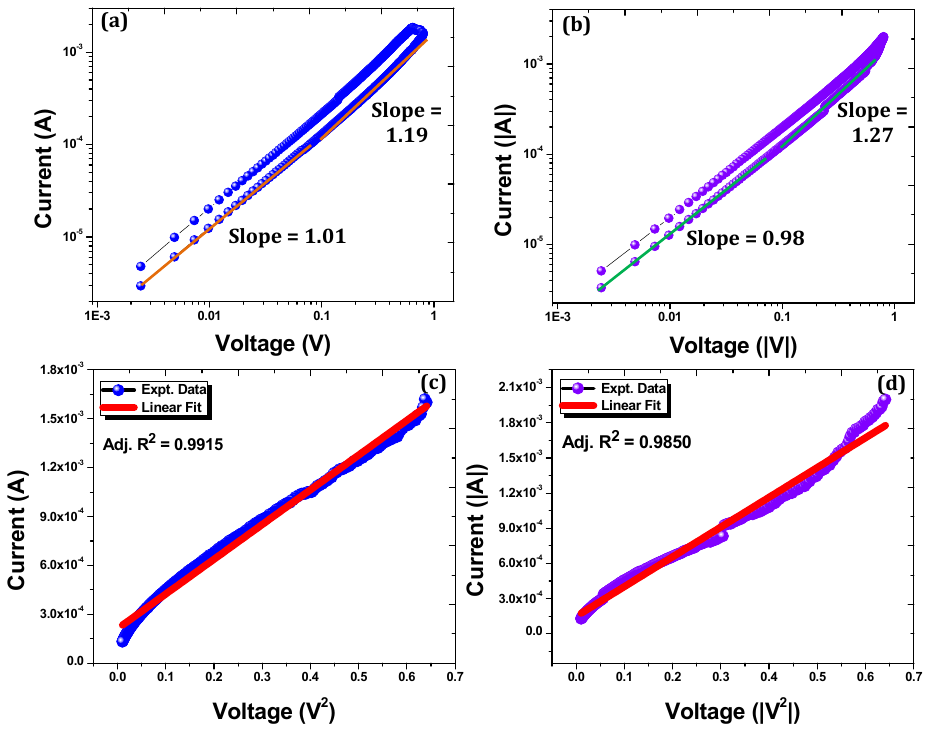
Figure 6. ( a ) Log–log I–V characteristics of the Ag/ZnO/FTO thin film memristive device during ( a ) positive and ( b ) negative bias. Child’s law plot: current vs. voltage 2 of the high slope part of the ( c ) positive and ( d ) negative bias data, respectively.